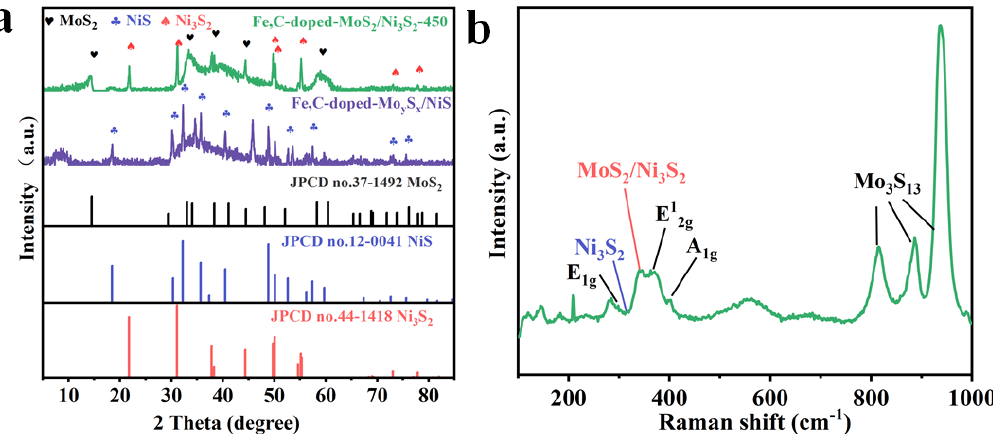
Figure 1. ( a ) XRD patterns of Fe, C-Mo y S x /NiS and Fe, C-MoS 2 /Ni 3 S 2 -450, ( b ) Raman spectrum of the Fe, C-MoS 2 /Ni 3 S 2 -450.